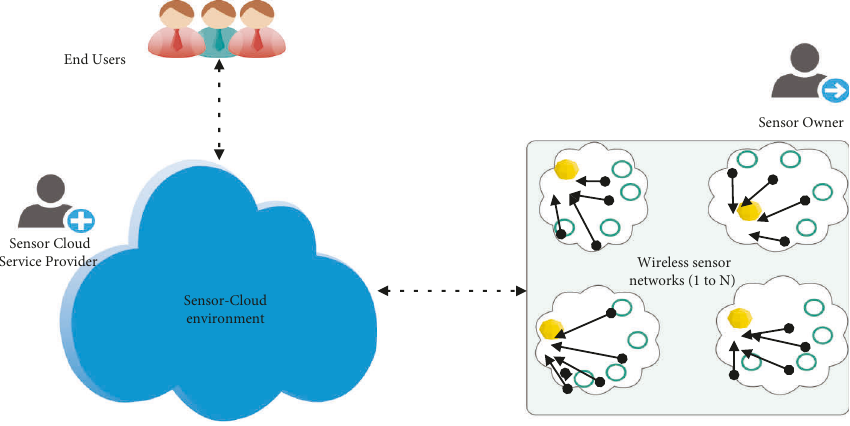
Figure 1: Sensor cloud